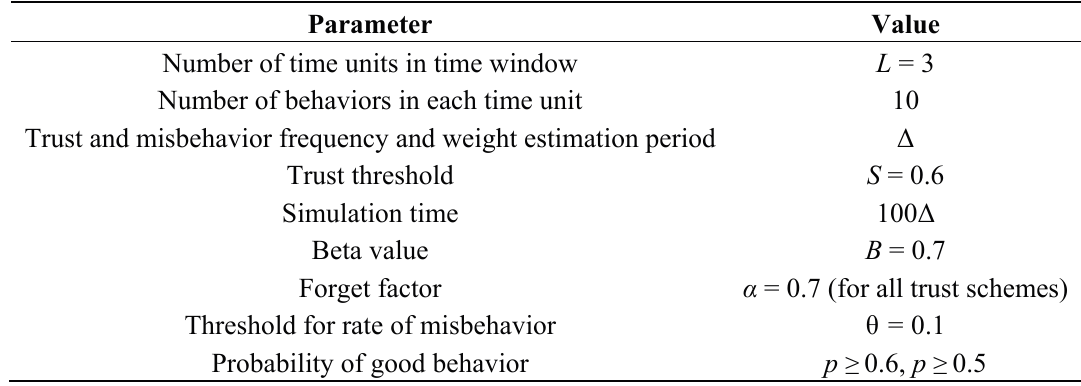
Table 2. Misbehavior detection simulation